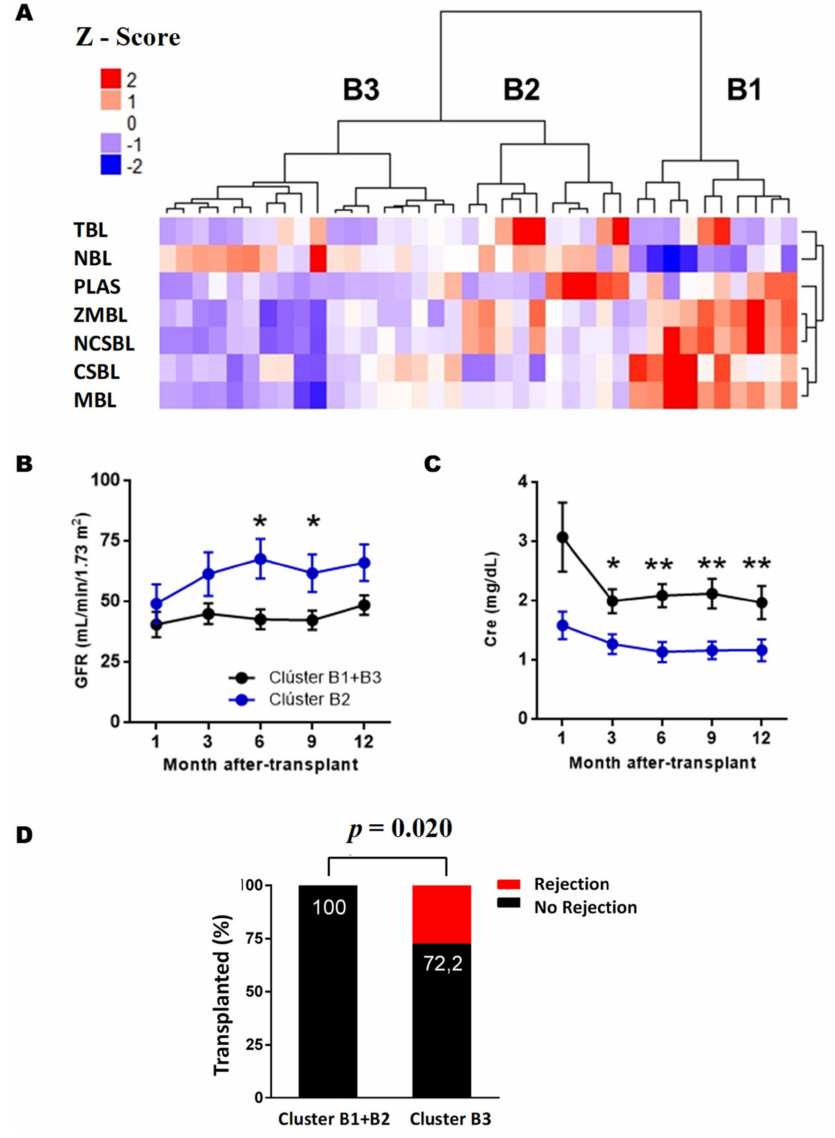
Figure 4. Analysis of the BL clusters at three months post-transplantation. ( A ) Heatmap represents a matrix in which the rows are the BL subpopulations and the columns the RTRs. The color grading represents the normalized values (Z-Score) obtained for each subpopulation. Evolution of the estimated glomerular filtration levels (FG) ( B ) and serum creatinine (Cre) ( C ) during the first year after transplantation of each cluster. In figure ( D ), the numbers on the bars’ black background indicate the percentage of RTRs free of rejection of each group. Data are represented as the mean ± SEM. Statistical analyses were performed using the Kruskal–Wallis test and Dunn’s posthoc test with Bonferroni correction for multiple comparisons. Values p < 0.05 were considered